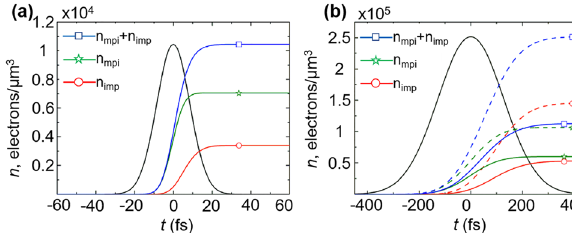
Figure 3: Simulated electron density dependency on time scale for the AI and MPI.